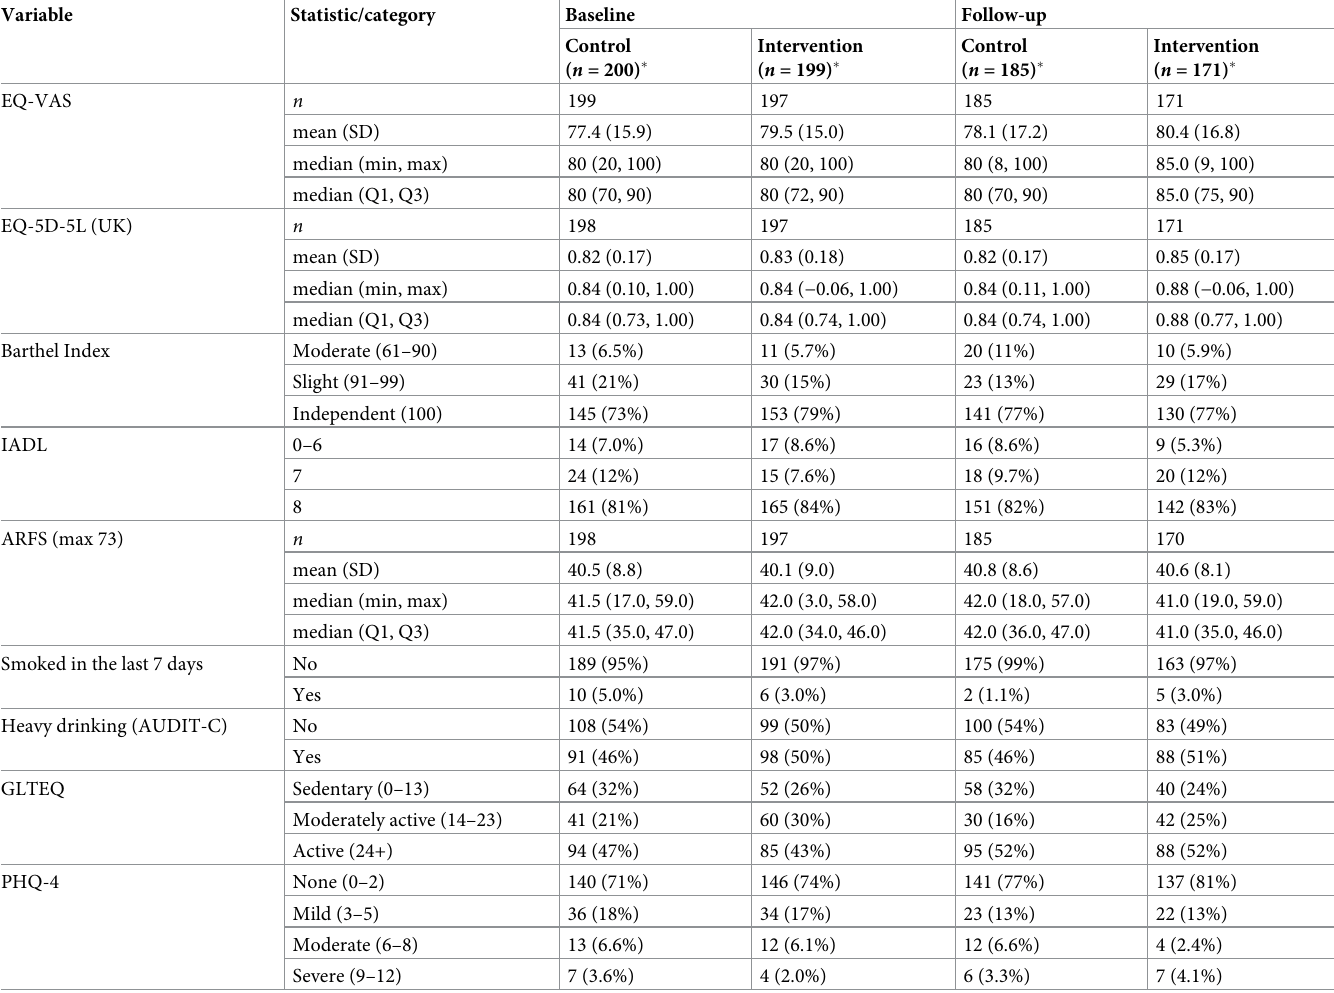
Table 2. Outcome variable descriptive statistics for baseline and follow-up time